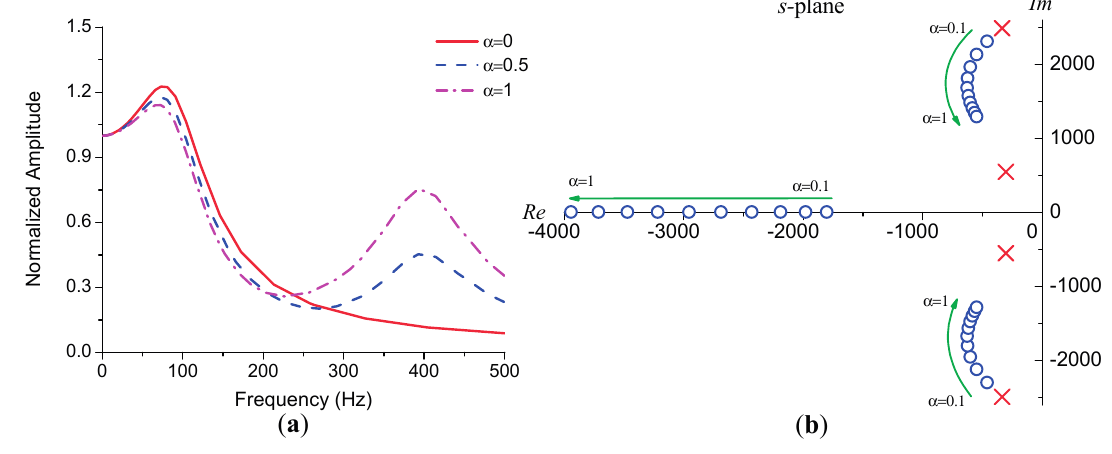
Figure 6. ( a ) The impact of the interference mode on the frequency response; ( b ) The movements of zeros and poles in s -plane as (cid:2009) gets